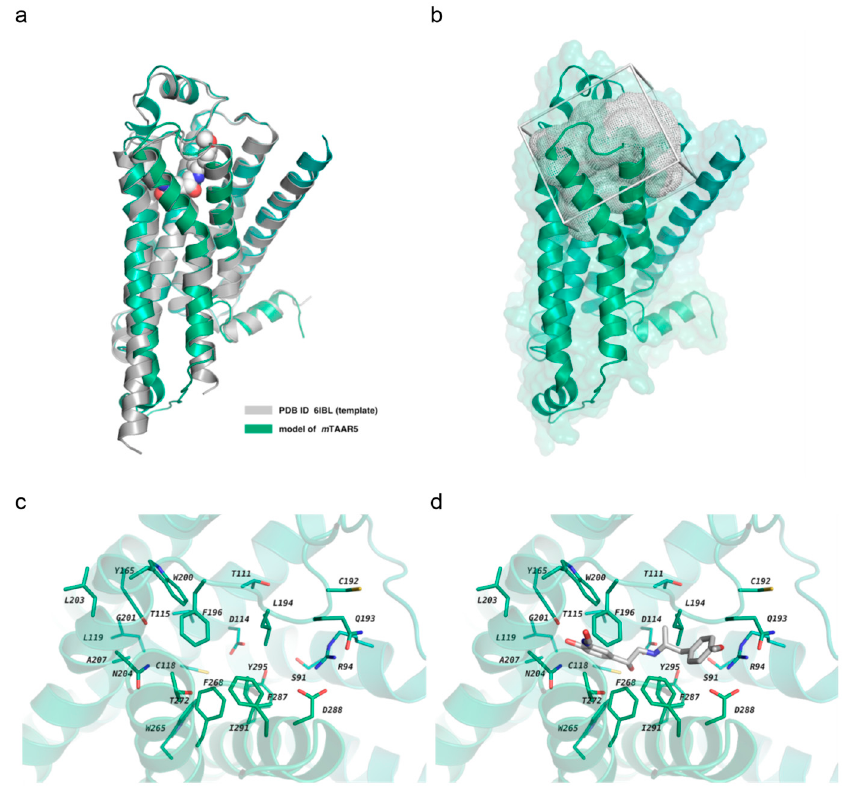
Figure 2. The homology model and the virtual screening sites of mTAAR5: ( a ) An overlay of the cartoon representation of constructed mTAAR5 model and homologous protein Meleagris gallopavo β 1-adrenoceptor with bound ligand shown as a sphere (PDB ID: 6IBL). ( b ) The grid box covered the screening site shown as mesh. ( c ) A close-up view of relevant residues of the binding site from the intracellular side, shown as sticks and labeled; ( d ) the same site as in ( c ), but with the bound ligand found in the template structure (PDB ID: 6IBL) shown white.